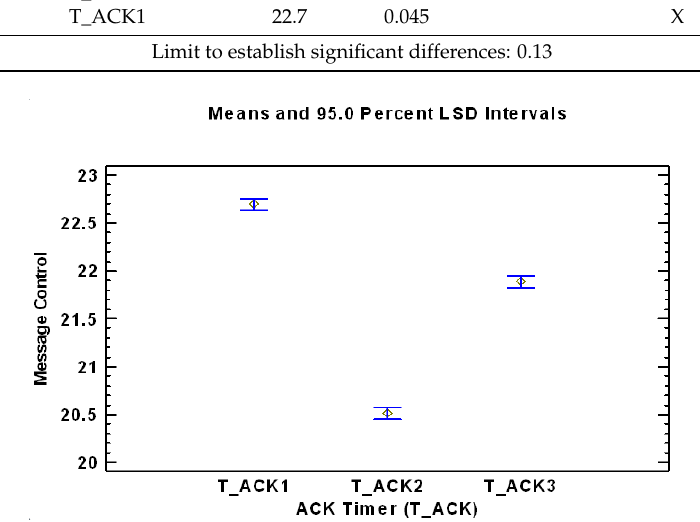
Figure 6. Mean values of the levels of the factor ACK Timer factor, analyzing the dependent variable Number of control messages sent during the set-up time.